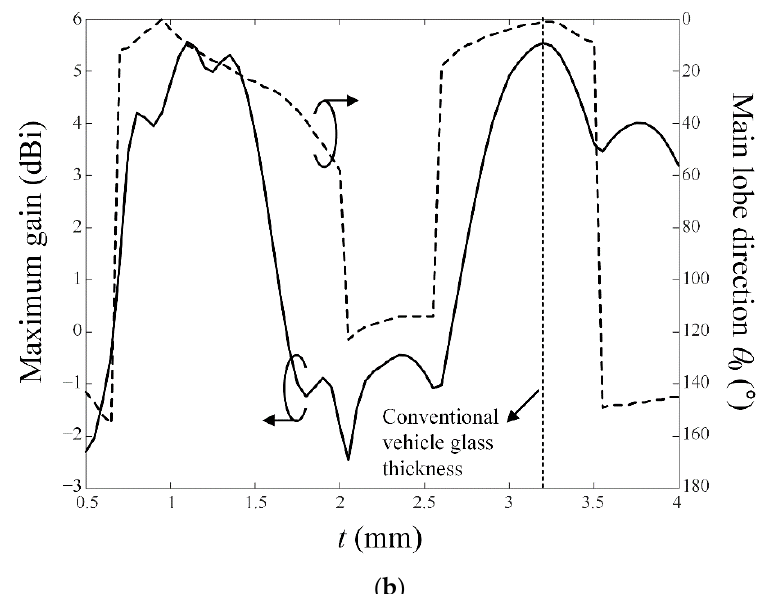
Figure 9. The maximum gain and main lobe direction θ 0 in accordance with parameter t : ( a ) conventional printed monopole antenna; ( b ) proposed antenna.